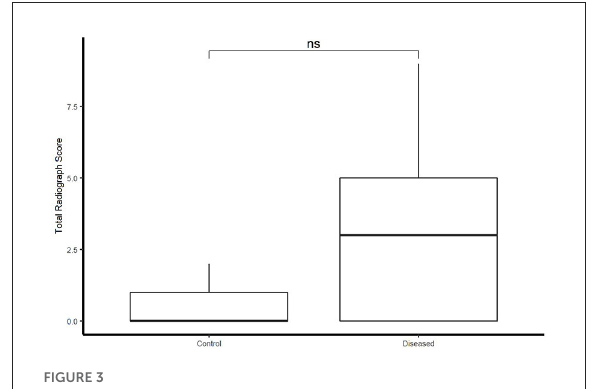
FIGURE3 Boxplot illustrating radiograph score between control and diseased group. Significance p < 0.05.